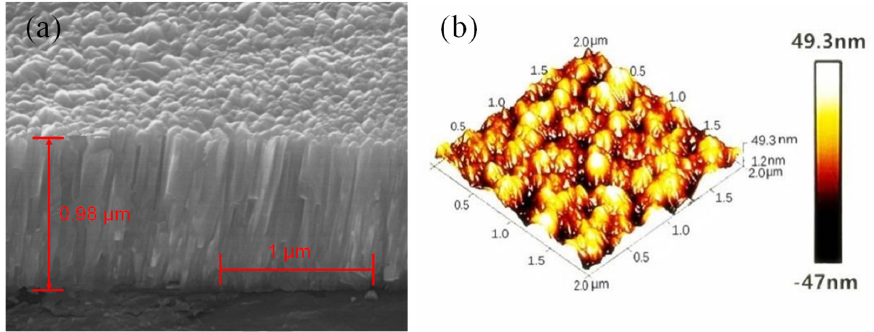
Figure 11. ( a ) SEM cross-sectional morphology and ( b ) AFM diagram of ZnO thin film.